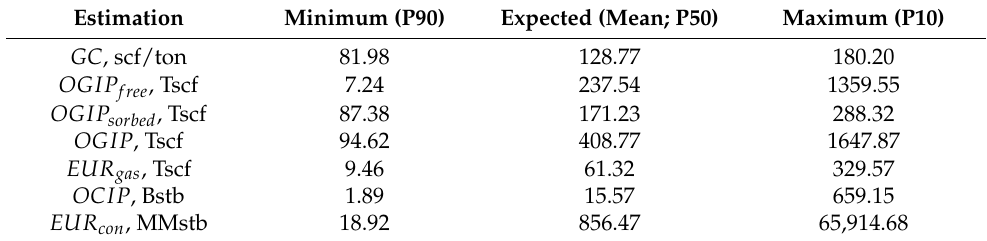
Table 6. EUR estimates for three